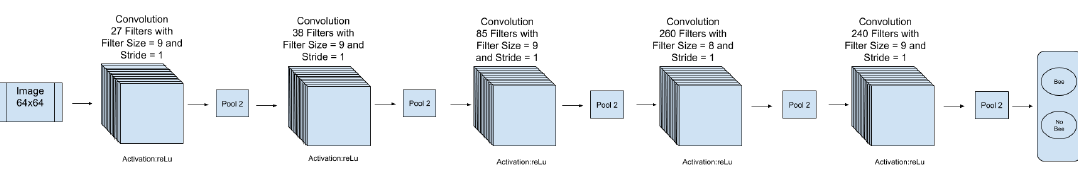
Figure A2. The architecture of ConvNetGS-4, the best performing auto-designed ConvNet on BEE2_1S.